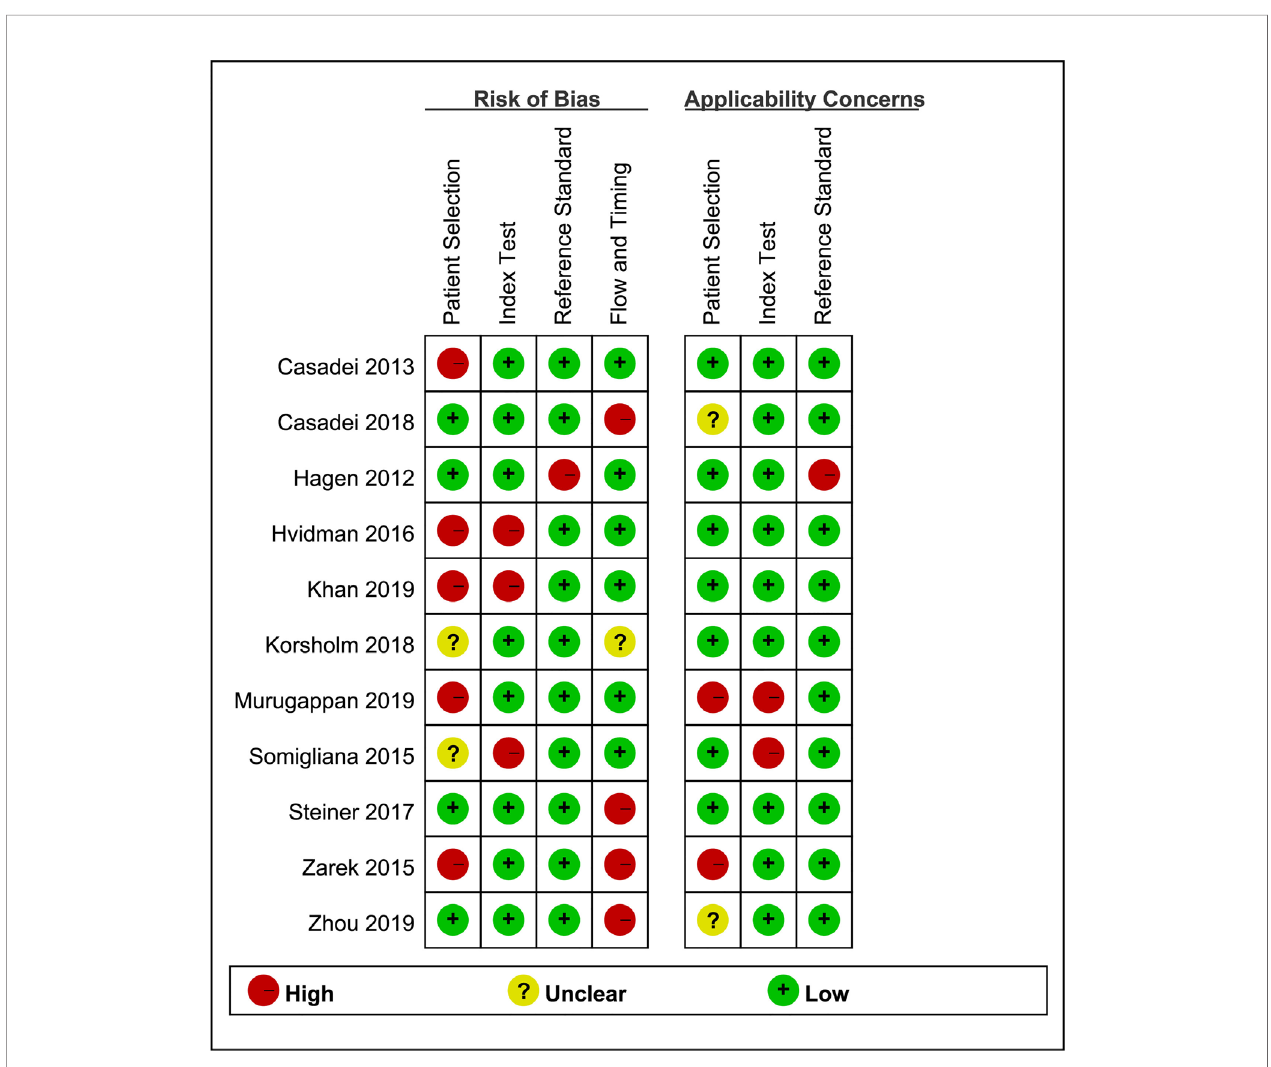
FIGURE 4 | Risk of bias and clinical applicability of the included studies.